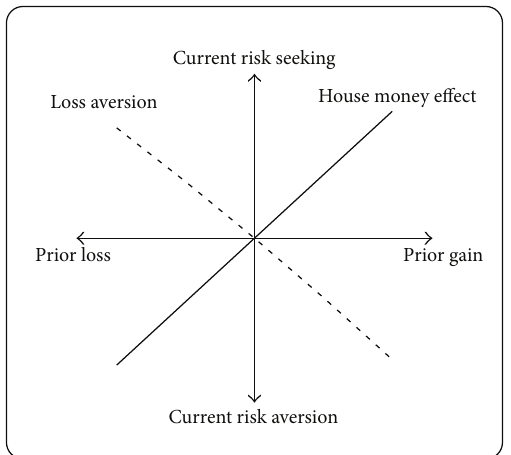
Figure 1: Hypothesized effects of prior loss and gain on current risk